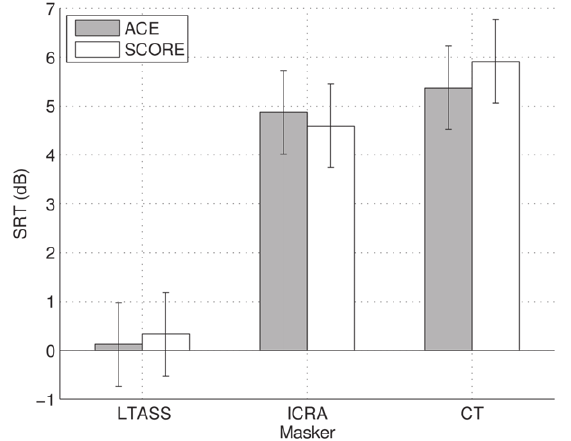
Figure 4. Speech in quiet results averaged across subjects. The total error bar length indicates Fletcher’s least significant difference.